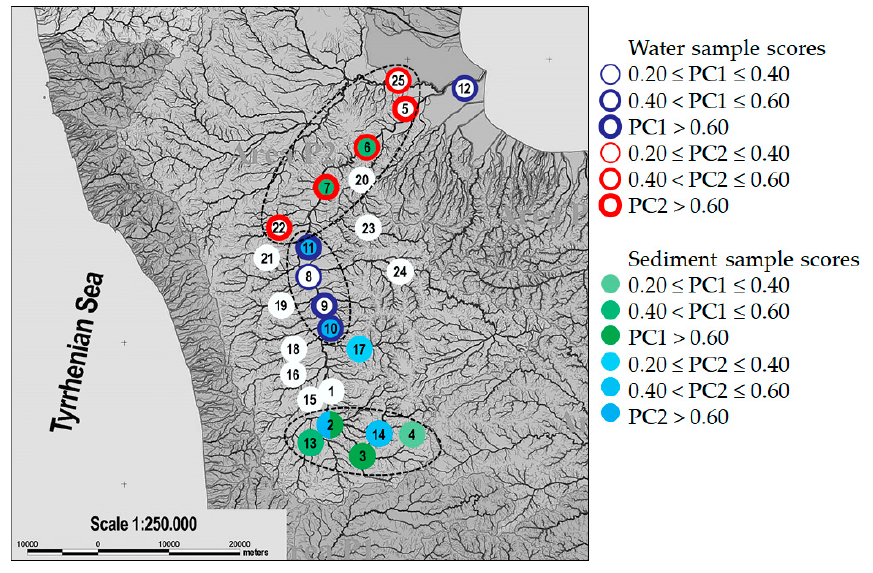
Figure 5. Risk map.